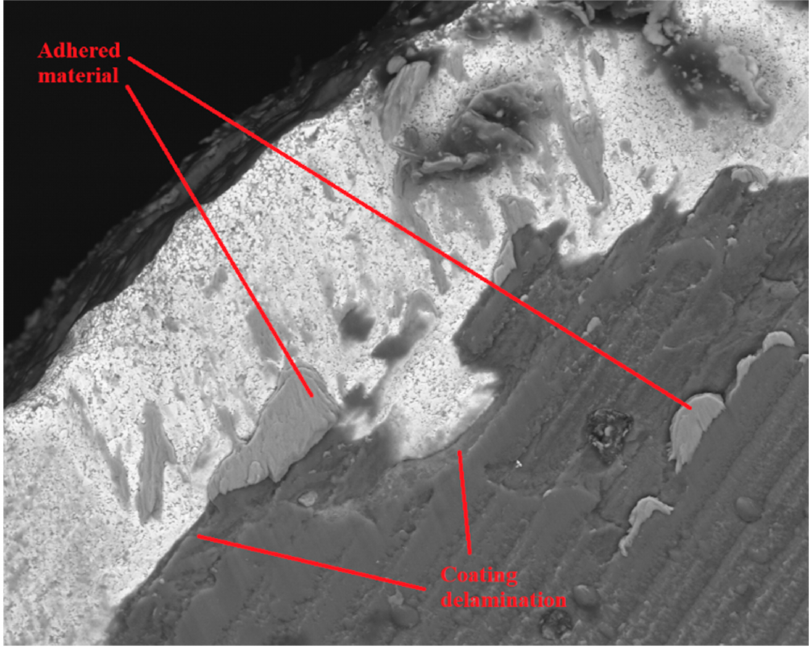
Figure 10. Material adhesion to delaminated areas of the TiAlSiN coatings, rake face of a T2L4F100 tool at 2500 ×